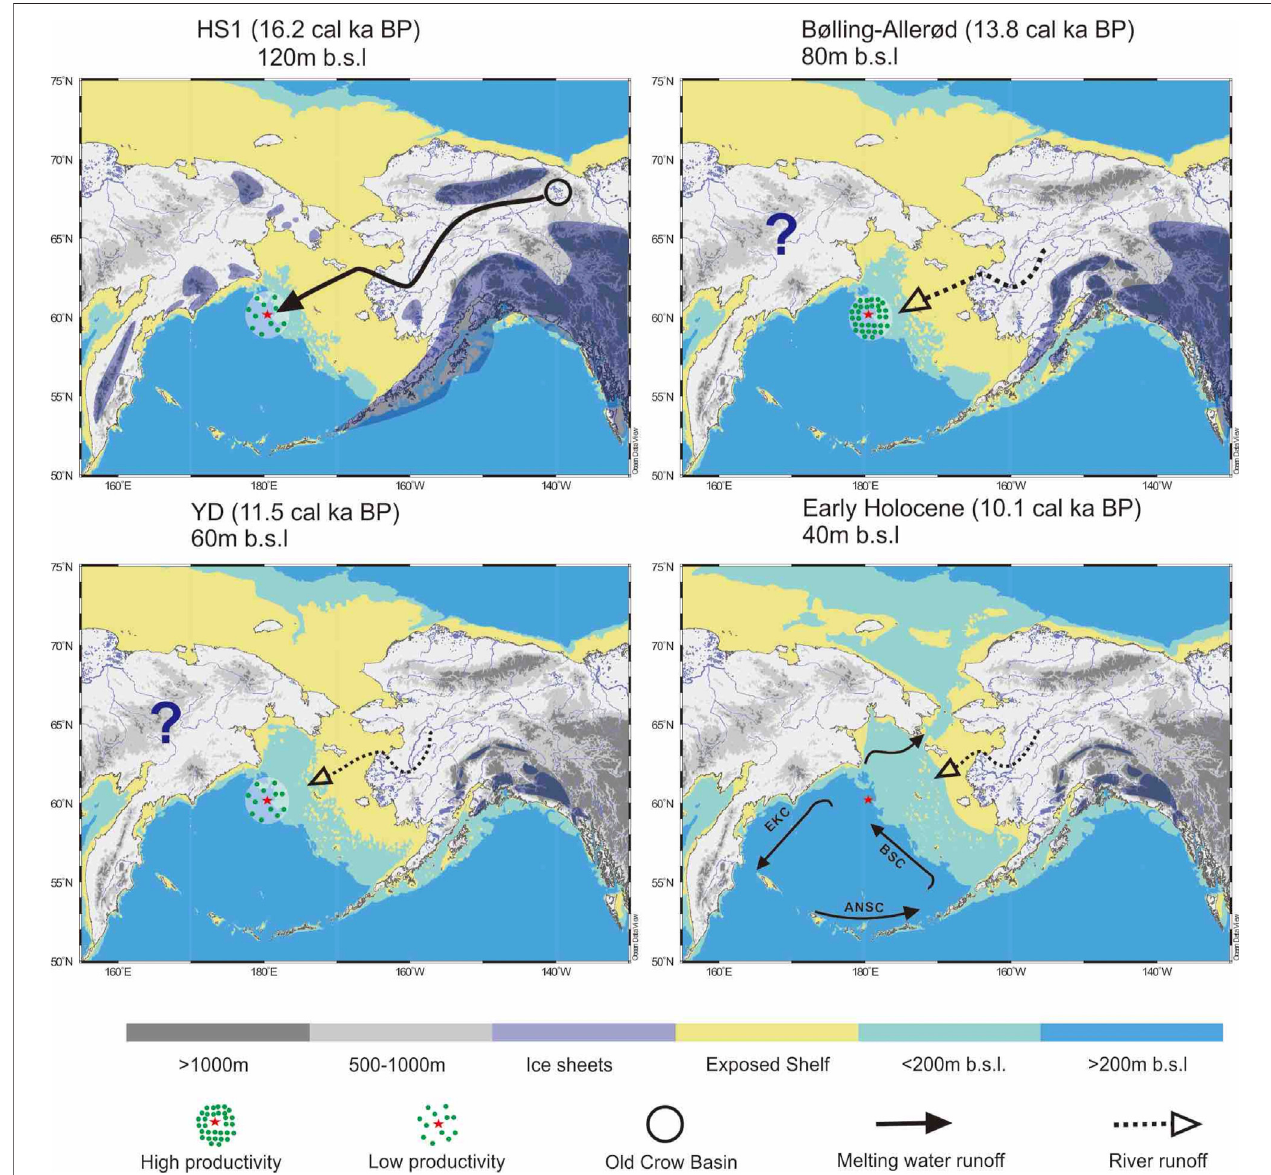
FIGURE 5 | Paleoenvironmental scenarios in the Bering Sea area during deglaciation, as inferred from this study. Map drawn with Ocean Data view (Schlitzer, 2002).GlacialextentandchronologyinAlaskaaccordingtoDyke(2004)andBrinerandKaufman(2008).ThetimingofdeglaciationontheSiberiansideisstillunclearand shows the maximum extent during the LGM (Barr and Clark, 2012). The con fi guration of river systems follows reconstructions by VanLaningham et al. (2009) and Bond (2019). Modern surface currents shown modi fi ed after Kim et al. (2015).